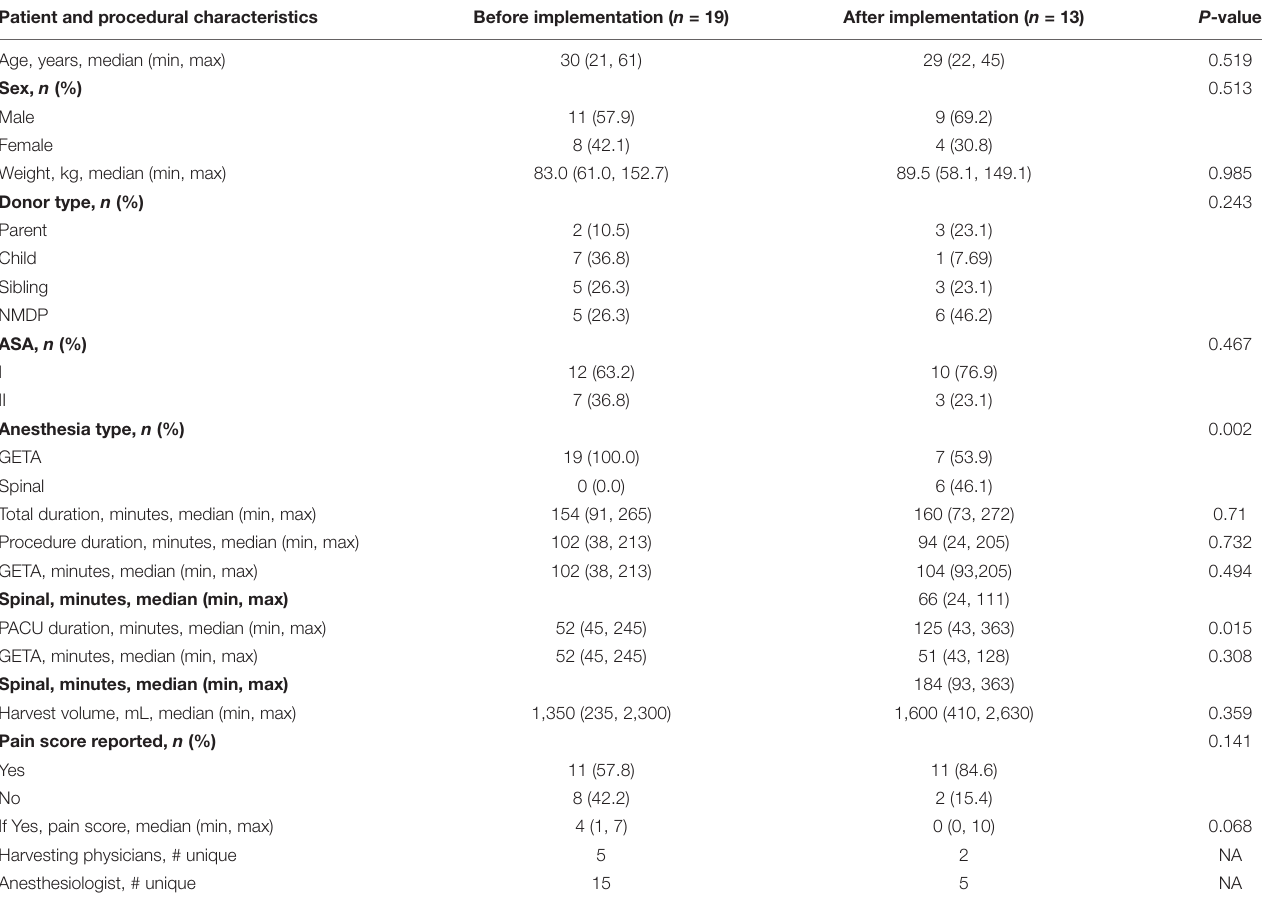
TABLE 1 | Patient and procedural